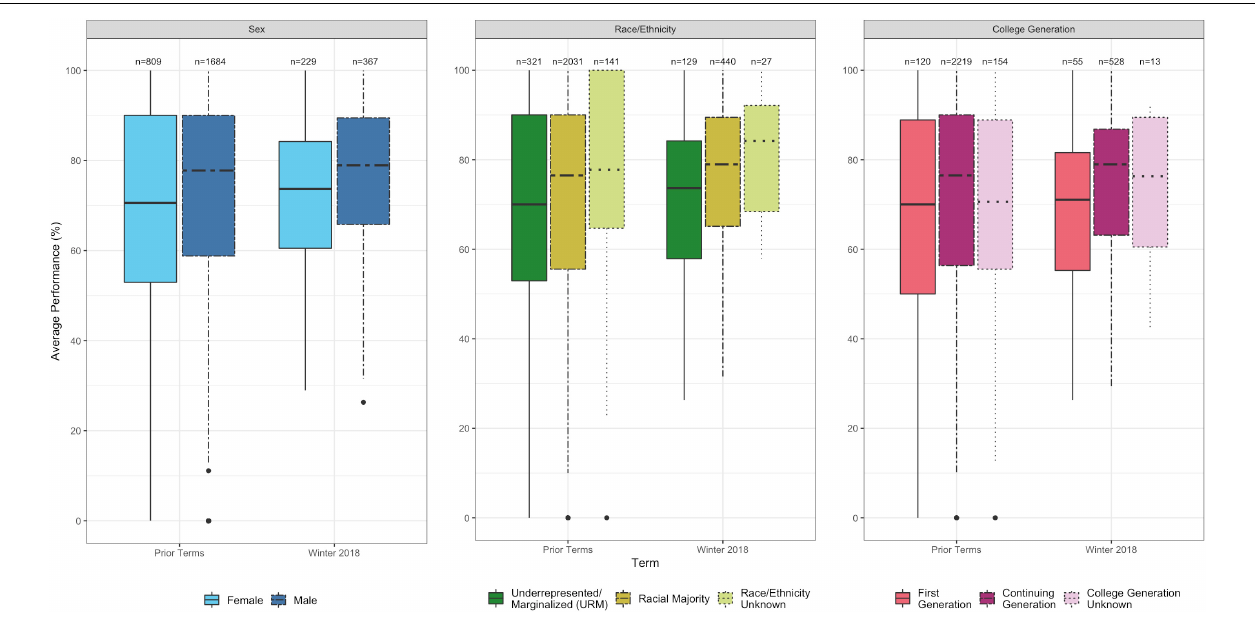
FIGURE 1 | Performance on Repeated Questions for different demographic groups. Prior Terms had standard exam time; Winter 2018 term had extended exam time.